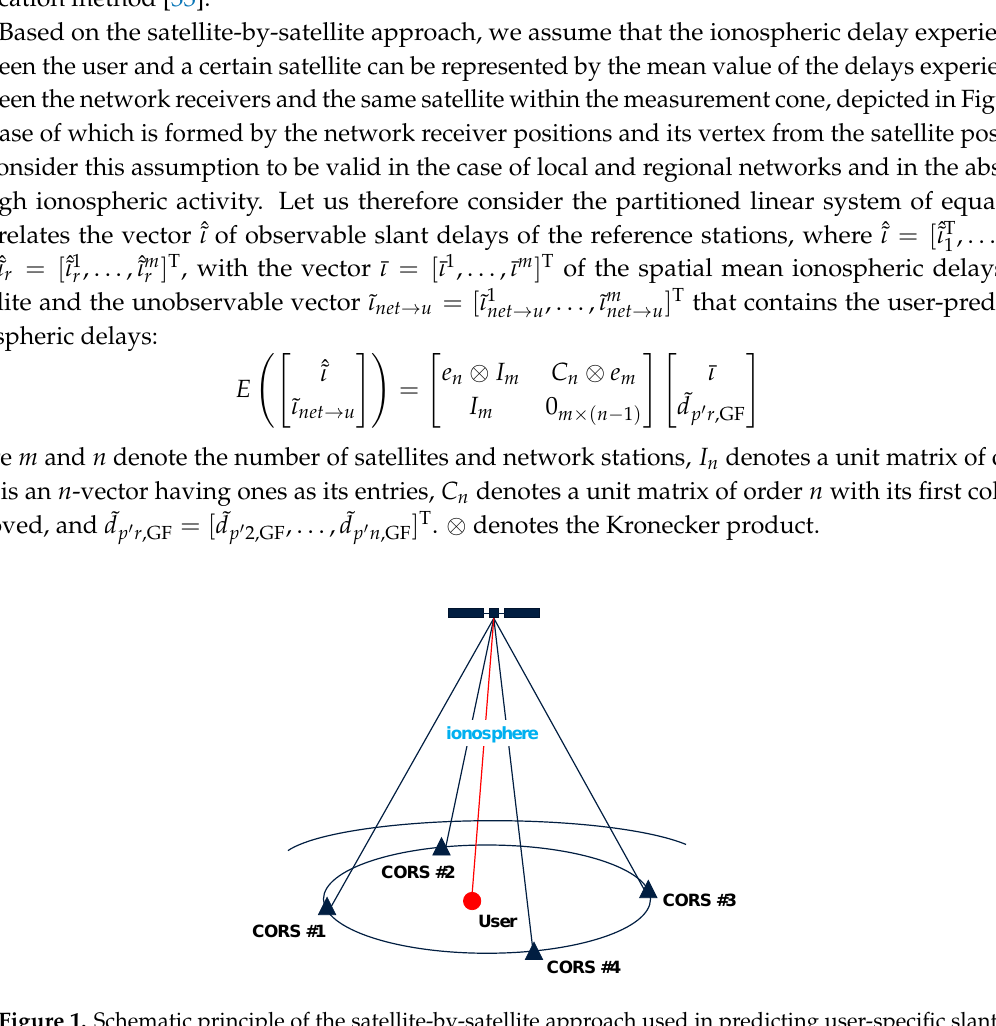
Figure 1. Schematic principle of the satellite-by-satellite approach used in predicting user-specific slant ionospheric corrections per satellite and per